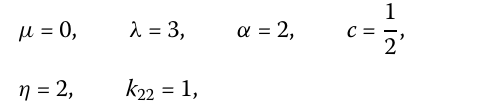
Figure 4 The figure of φ I 3 ( ξ